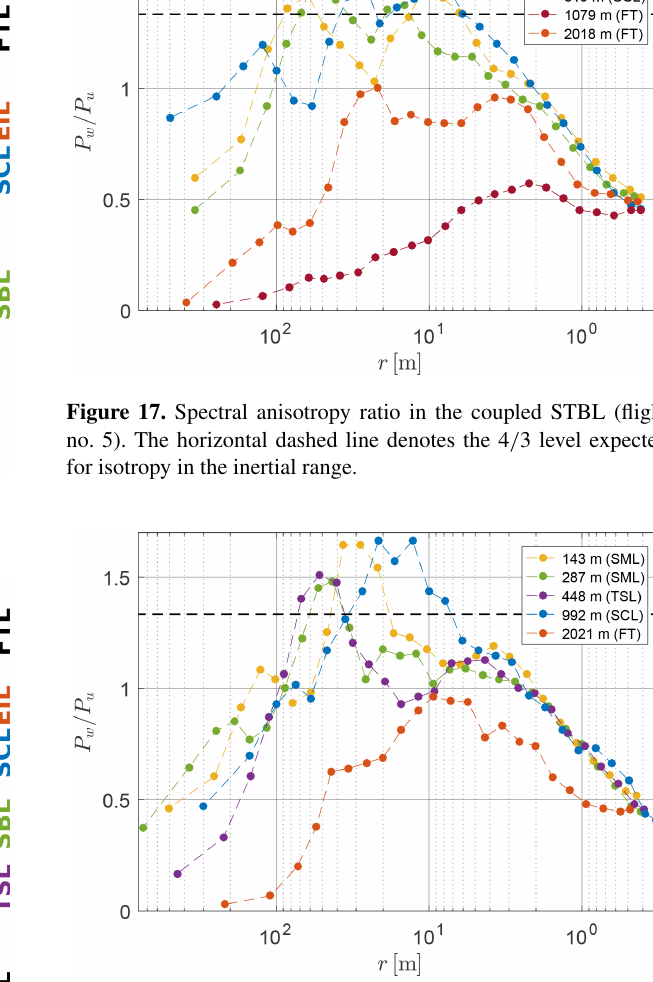
border in the TSL. In the upper part, covering the SCL and the SBL, A sfc and A psd (cid:15) are visibly smaller than in the SML. (cid:15)